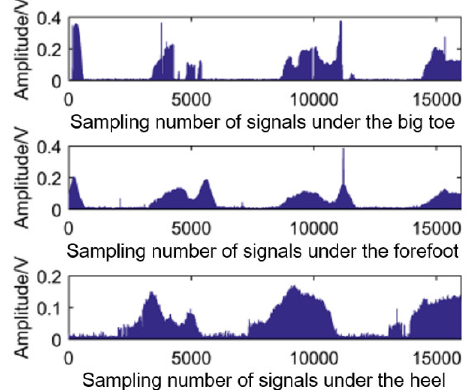
Figure 9. The raw plantar pressure signals.